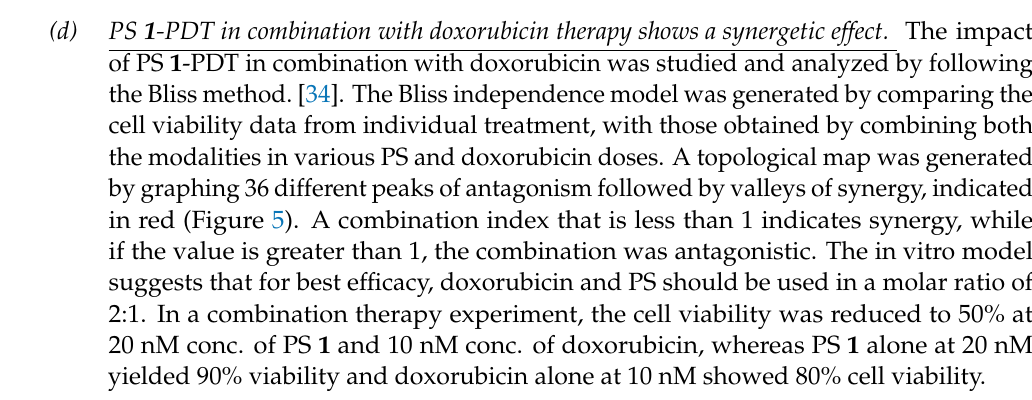
Figure 4. The in vitro cytotoxic effect of PS 1 -PDT at variable concentrations/light doses and doxoru- bicin efficacy at variable concentrations after incubating for 48 h were independently determined in A549 cell lines. For the PDT experiment, the cells were exposed to light at 24 h. Cells were then rested for 48 h and tested for cytotoxic effects via MTT assay. The cells were incubated with doxorubicin for 48 h and then tested for cytotoxicity by MTT